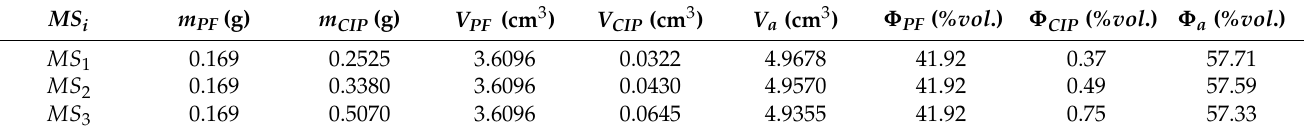
Table 1. Weights, volumes and volumetric fractions for MS i , where i = 1, 2, 3 denote sample numbers.